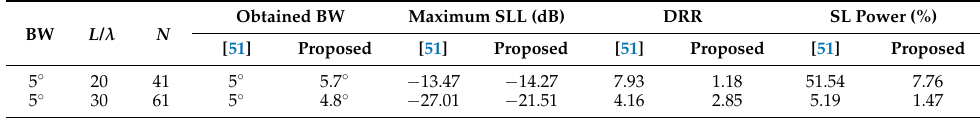
Table 2. ES: performance comparison between different